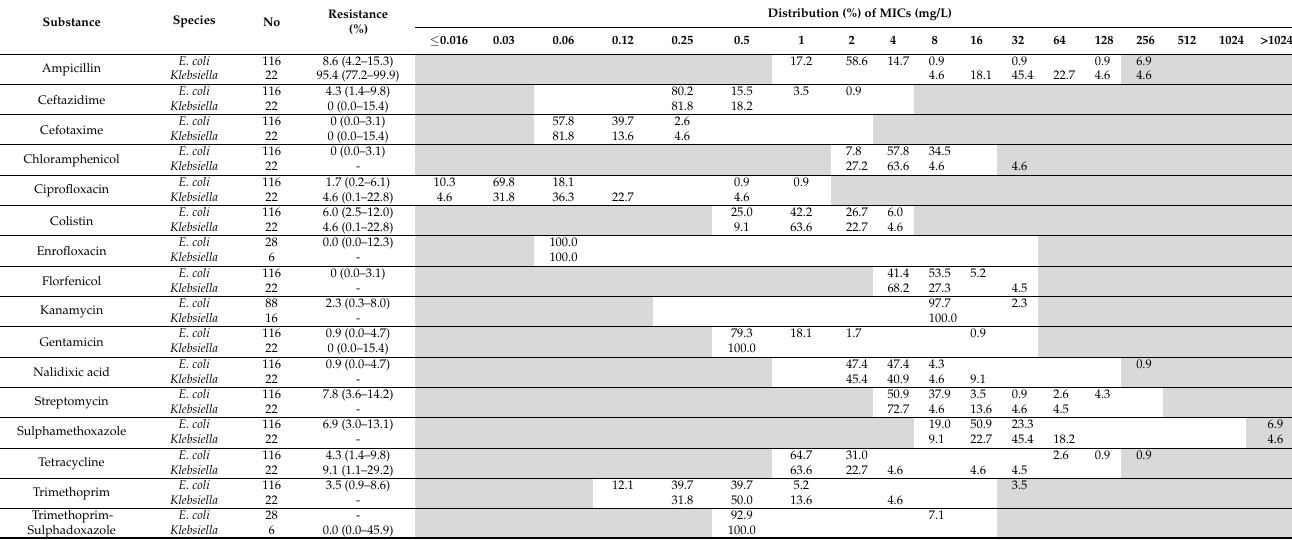
Table 4. Number of tested isolates (No), resistance (per cent, 95% CI in brackets), and MIC distribution (%) for Escherichia coli and Klebsiella spp. isolated from cases of clinical mastitis in dairy cows. White fields indicate test range for each antibiotic.